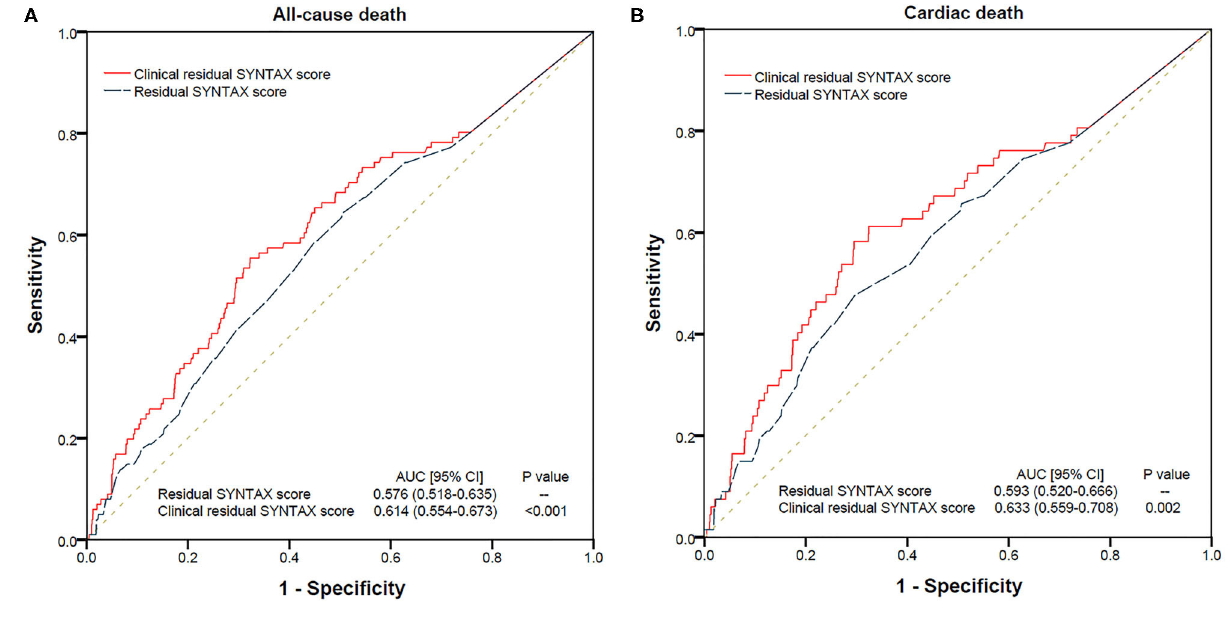
FIGURE 4 | Comparison of ROC Curves between RSS and CRSS for Predicting Long-term All-cause (A) and Cardiac (B) mortality. AUC, area under the curve; CRSS, clinical residual SYNTAX score; ROC, receiver operating characteristic; RSS, residual SYNTAX score.